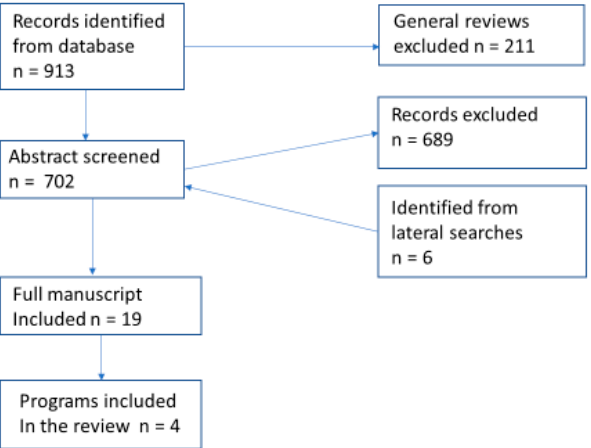
Figure 3. Overview of the study selection process.